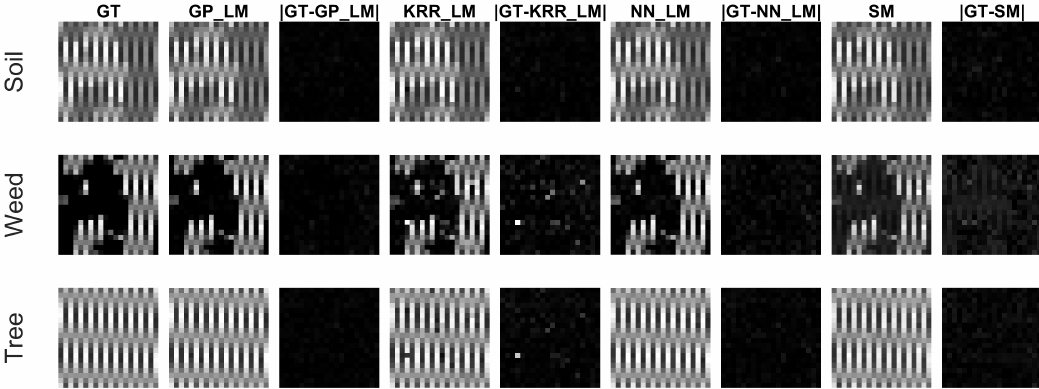
Figure 9. Ground truth (GT) and estimated abundance maps and absolute difference with the GT for the four proposed supervised methods on the ray tracing dataset. All images are normalized by the largest abundance value in the GT